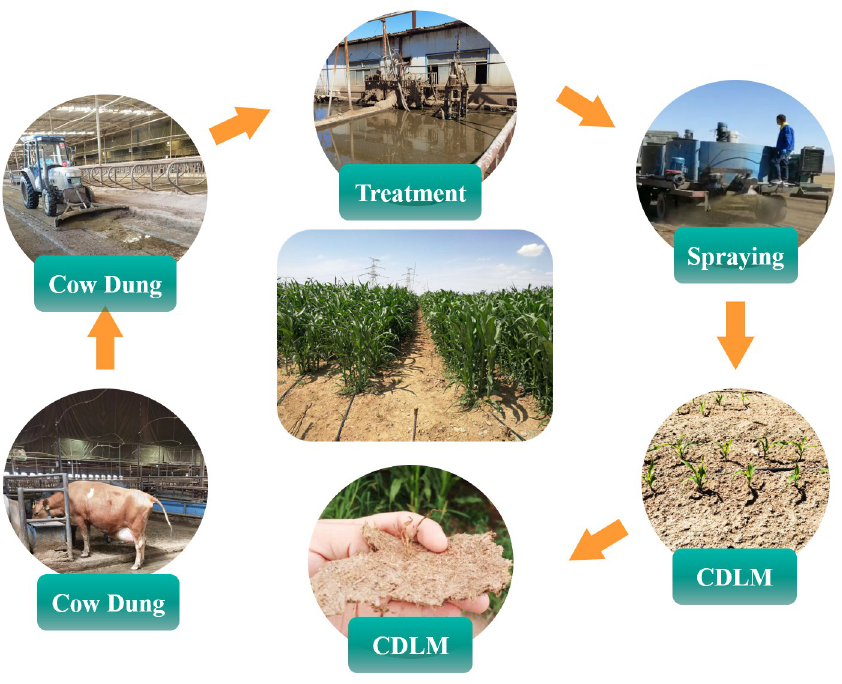
V12 (twelfth leaf), V15 (fifteenth leaf), and VT (tasseling). The RS stage includes R1 (Silking), R2 (Blister, 10~14 days after Silking), R3 (Milk, 18~22 days after Silking), R4 (Dough, 24–28 days after Silking), R5 (Dent, 35–42 days after Silking), R6 (Physiological maturity, 55–65 days after Silking).